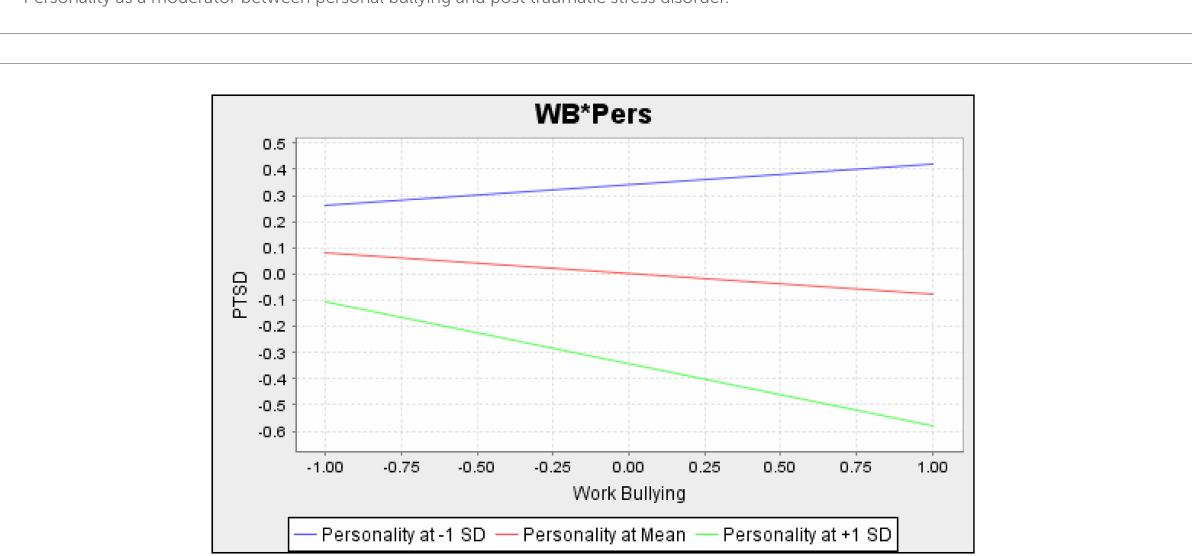
FIGURE5 Personality as a moderator between personal bullying and post traumatic stress disorder.